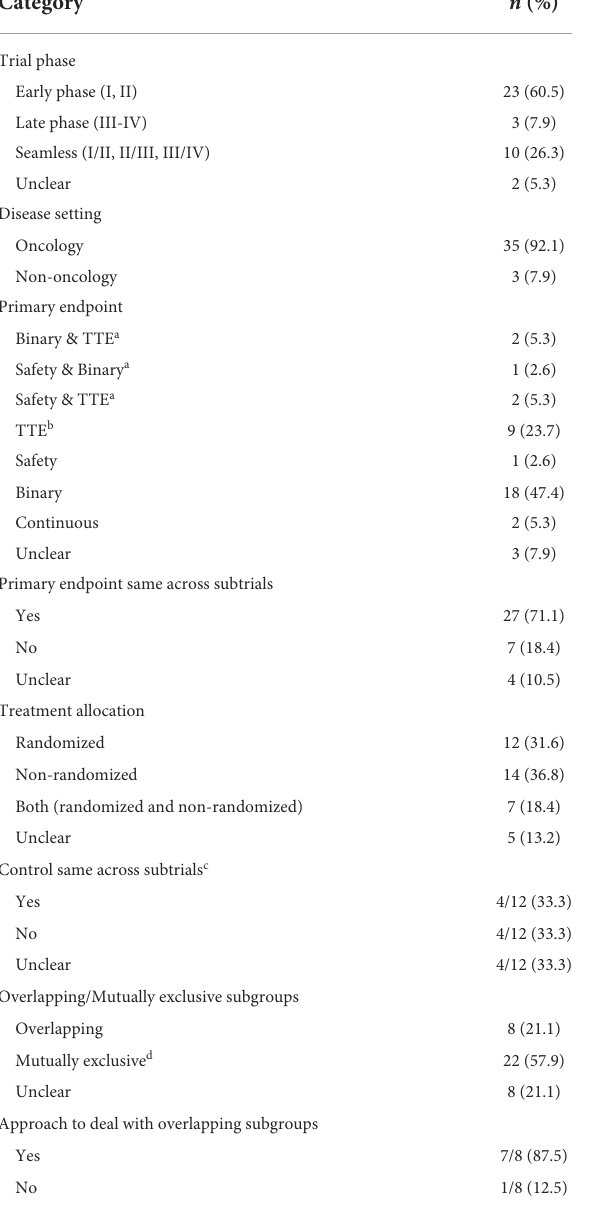
TABLE 2 Statistical considerations in the design and analysis of the 38 identified umbrella